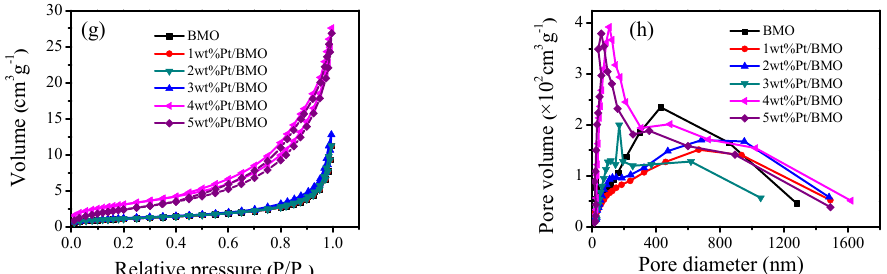
Figure 6. N 2 adsorption–desorption isotherm curve (Brunauer-Emmett-Teller, BET) of γ -Bi 2 MoO 6 with: ( a,b ) di ff erent preparation methods, ( c,d ) di ff erent hydrothermal temperatures, and ( e,f ) di ff erent pH values and N 2 adsorption–desorption isotherm curve (BET) of Pt / γ -Bi 2 MoO 6 with ( g,h ) di ff erent mass fraction of Pt. Table 1. Specific surface areas of the di ff erent catalysts.